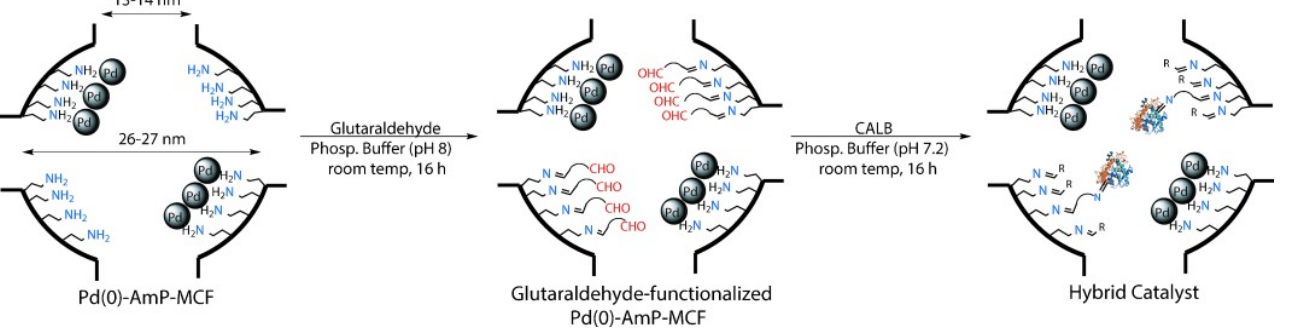
Figure 6. Co-immobilization of Pd and CAL-B into pores of siliceous mesocellular foam [169]. Reprinted from [169] with license of John Wiley and Sons.